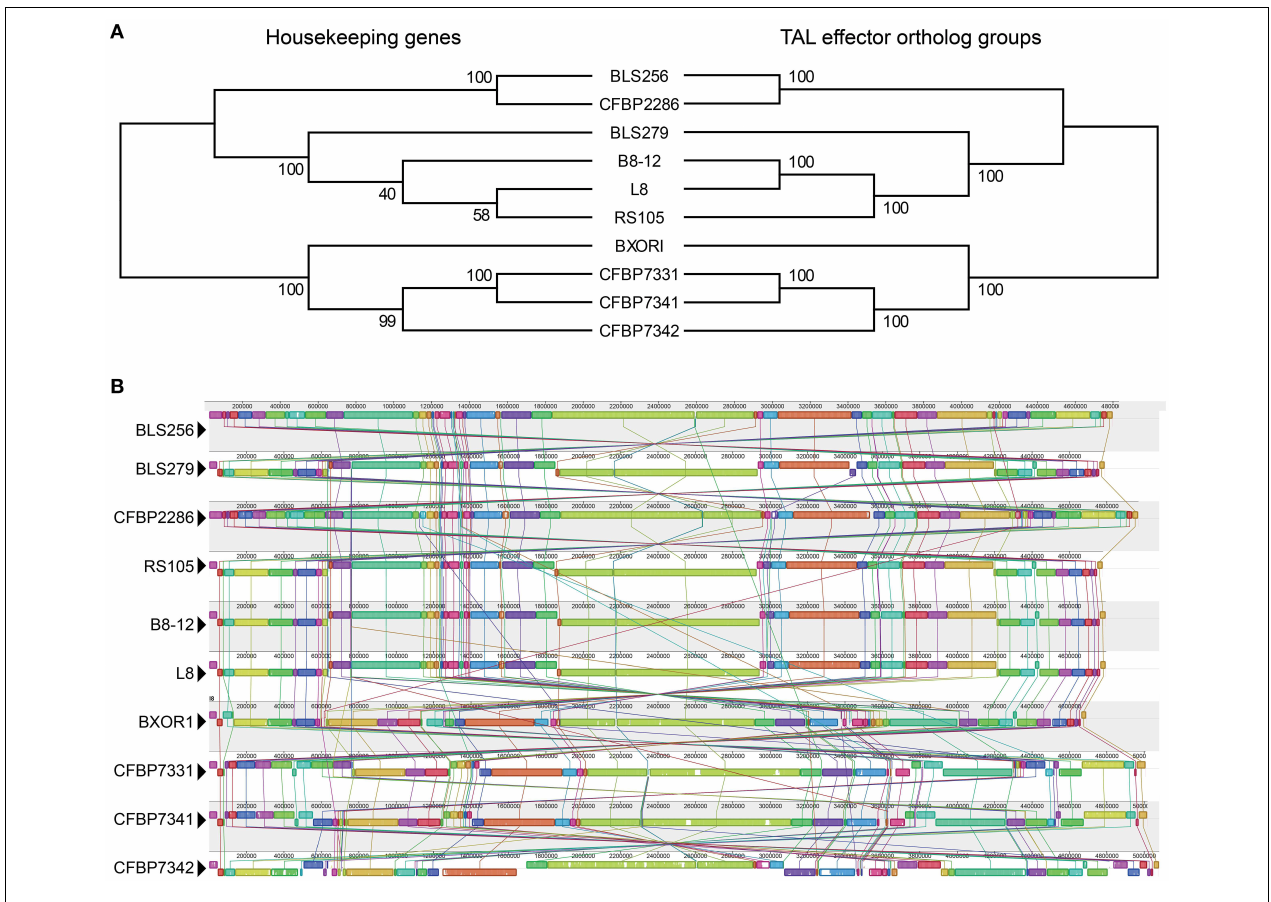
of every strain, generated using progressiveMauve ( Darling et al., 2010). Colored blocks represent regions of uninterrupted homology, connected between genomes by matching colored lines. The height of the colored bars within each block indicates relative conservation on average across all genomes. Homologous regions above the centerline are in the same orientation as they are in BLS256 and those below are